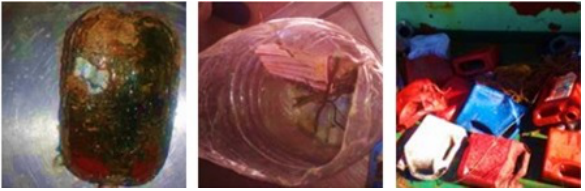
Figure 3. Examples of marine debris items collected during the prospection surveys in the prospected area.